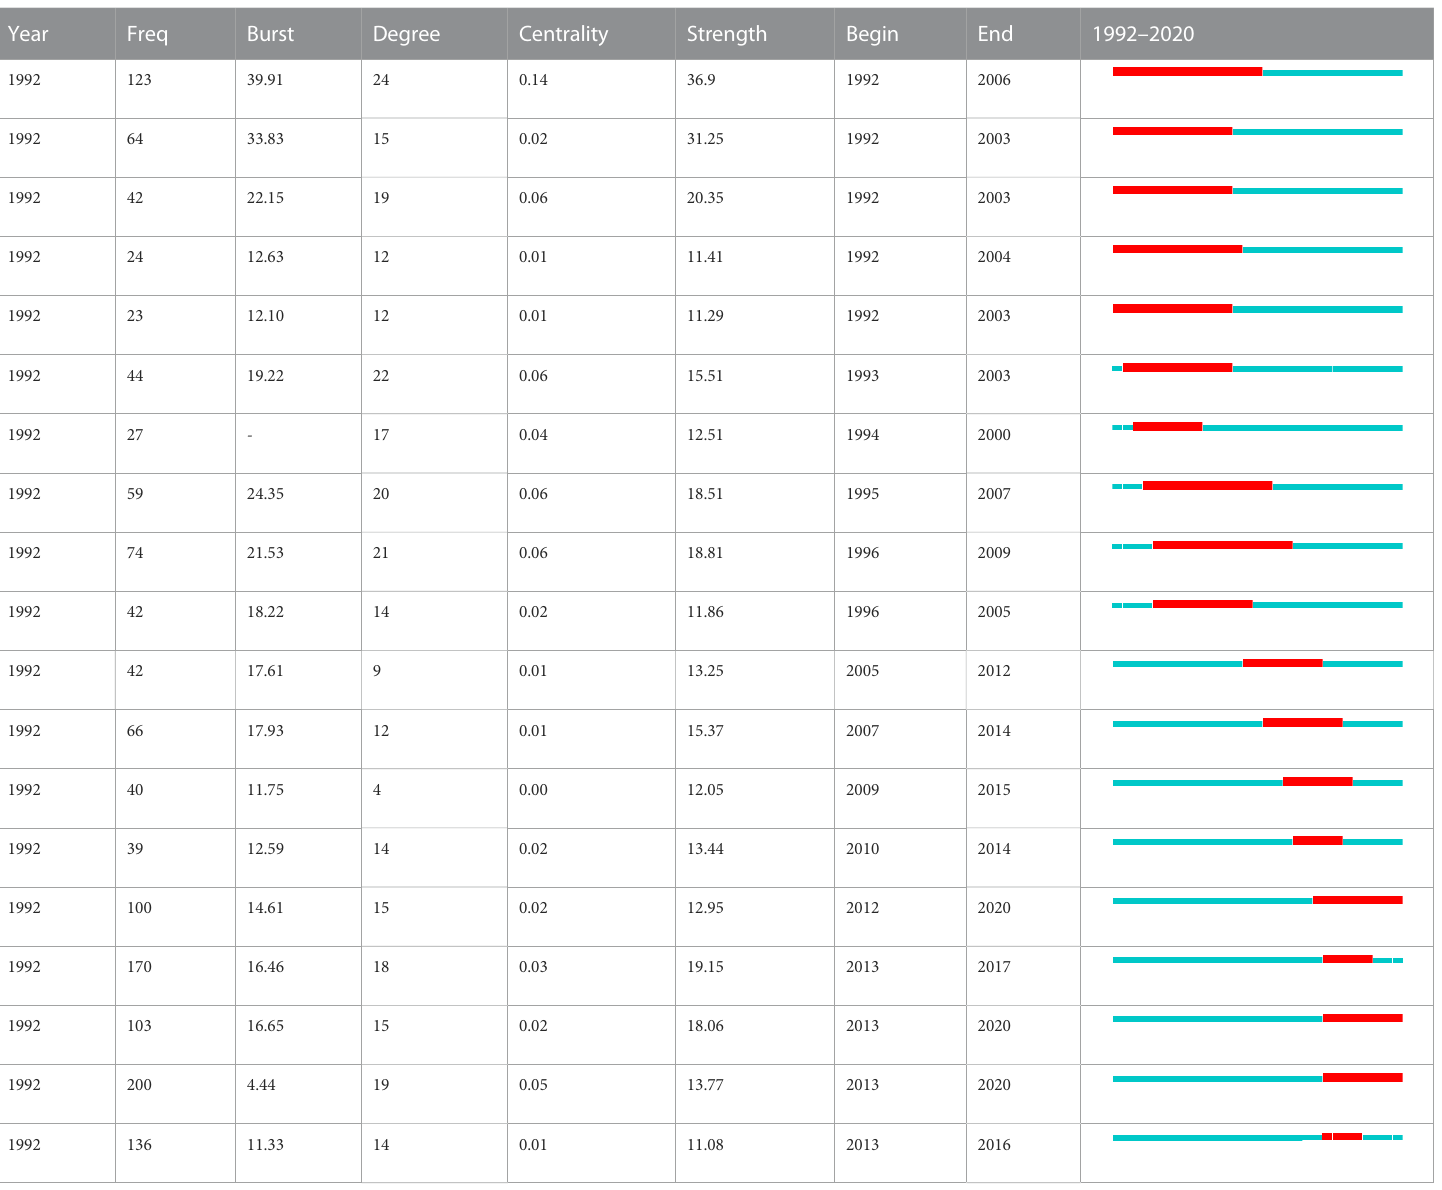
TABLE 4 Top keywords with the strongest citation